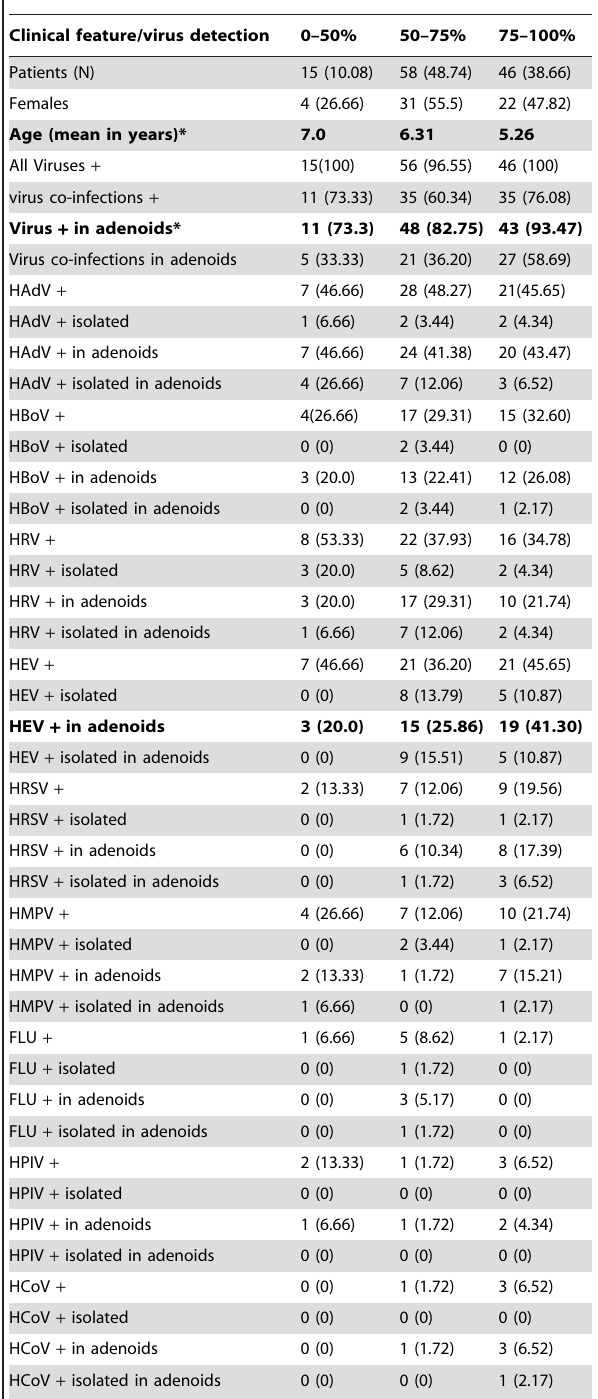
Table 5. Demographic data and virus detection frequencies in patients according to adenoid sizes.